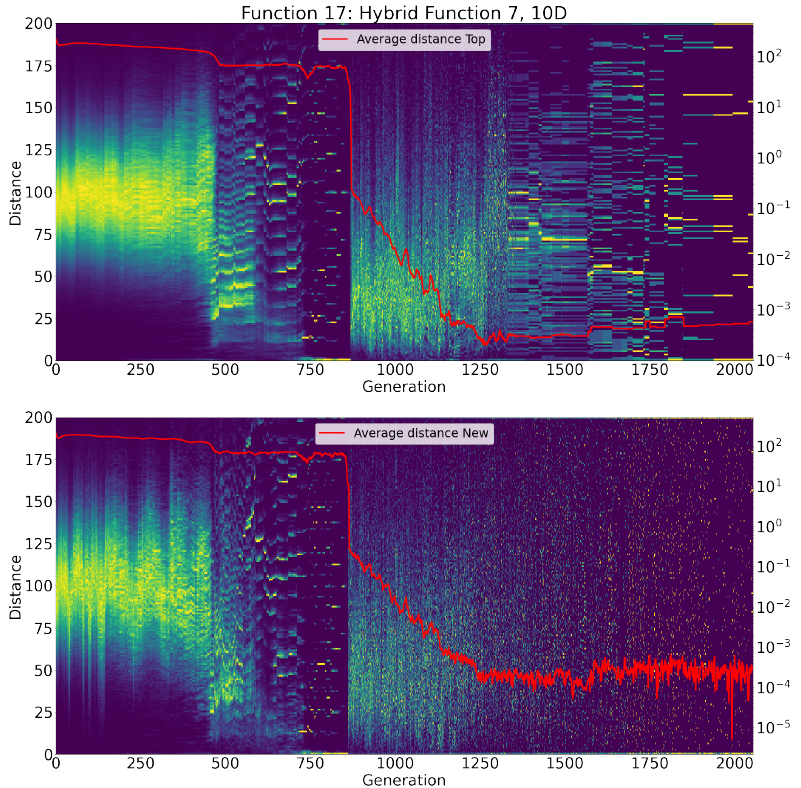
Figure 3. Heatmap of pairwise distance histograms on every generation, F17, CEC 2017, 10 D